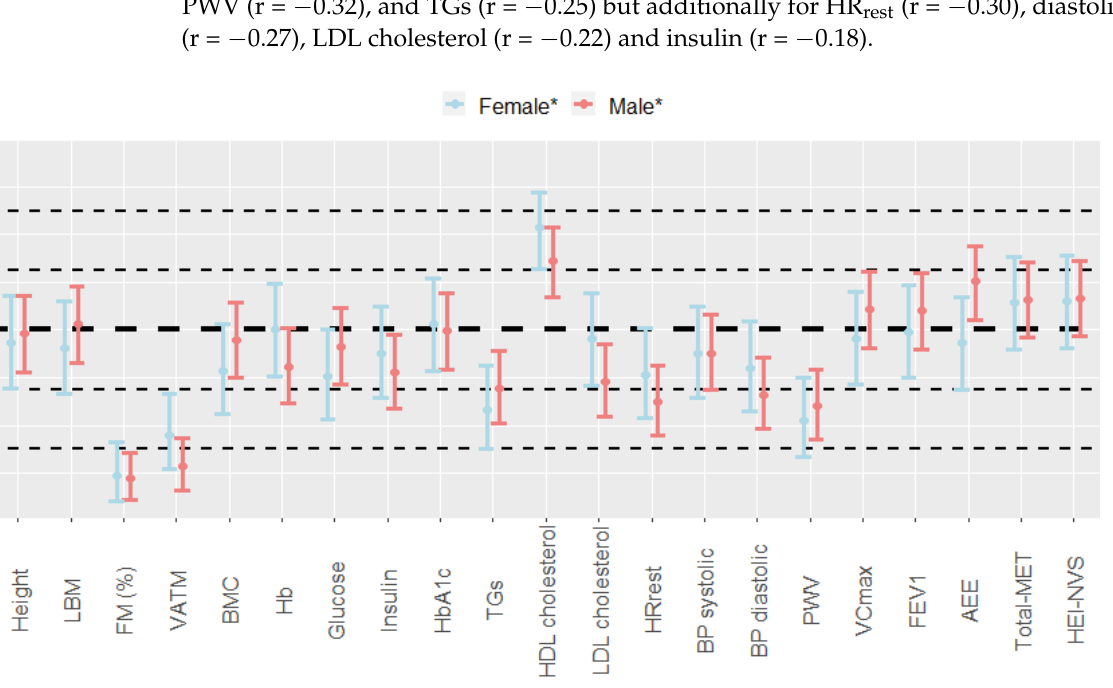
Figure 2. Confounder-adjusted sex-specific correlations between the VO 2peak and phenotypical/clinical variables. * Pearson correlations were performed on Van der Waerden (VdW)-transformed data adjusted for age (and menopausal status in females) and respective correlation coefficients (r; dots) and 95% confidence intervals (CIs; bars) are illustrated. AEE: activity energy expenditure; BMC: bone mineral content; BP: blood pressure; FEV1: forced expiratory pressure in one second; FM: fat mass; Hb: hemoglobin; HDL: high-density lipoprotein; HEI-NVS: Healthy Eating Index (modified version); HR rest : resting heart rate; LBM: lean body mass; LDL: low-density lipoprotein; MET: metabolic equivalent of task; PWV: pulse wave velocity; TGs: triglycerides; VATM: visceral adipose tissue mass; VC max : maximal vital